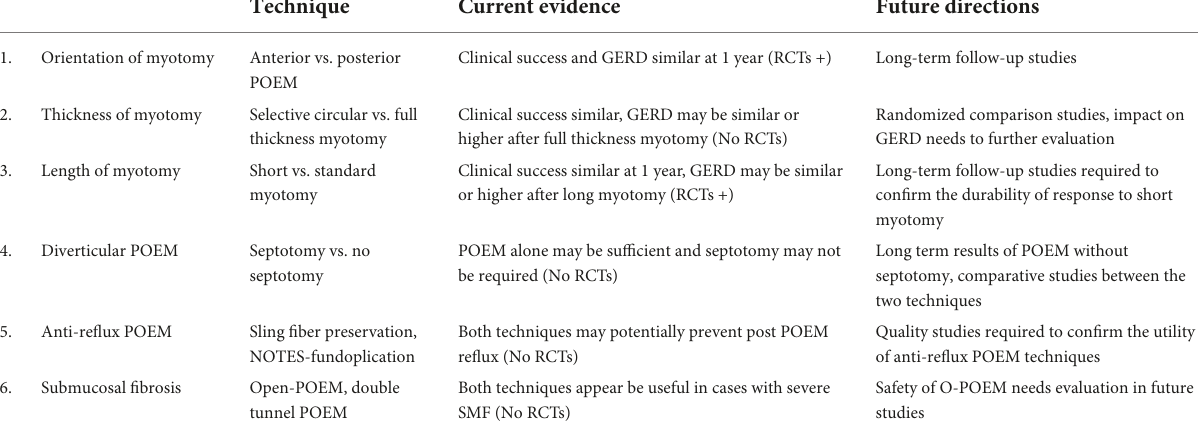
TABLE 1 Modified techniques of peroral endoscopic myotomy: Current status and future